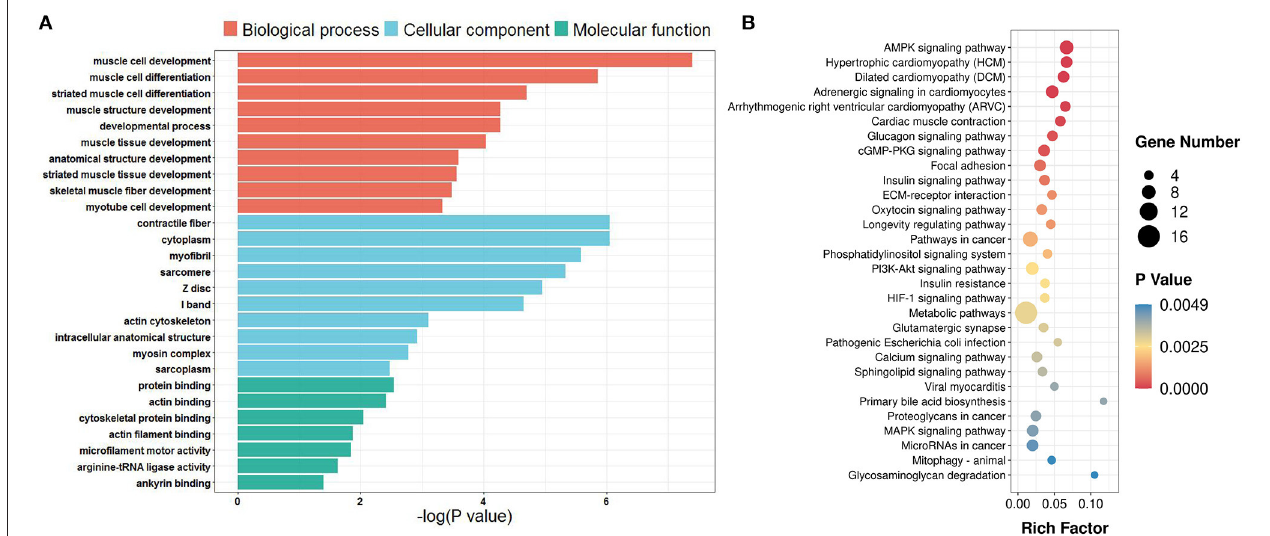
FIGURE 5 | GO and KEGG enrichment of genes with differential editing levels. (A) GO enrichment terms; (B) KEGG pathway enrichment terms. Rich Factor is the ratio of differentially edited gene numbers annotated in this pathway term to all gene numbers annotated in this pathway